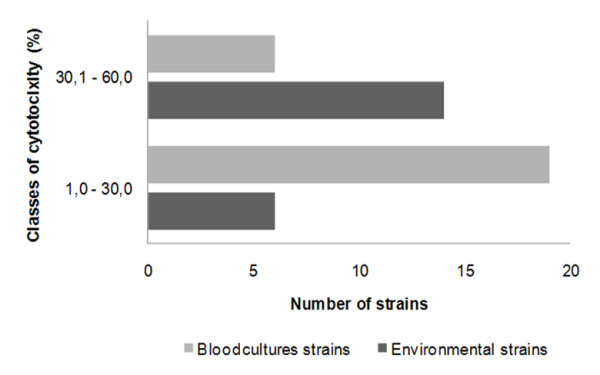
Distribution of C. parapsilosis environmental and blood isolates, according to the defined classes of cytotoxicity. The majority of environmental isolates are included in the group causing between 30 and 60% cytotoxicity. Cellular damage induced by the yeast was quantified as the amount of LDH release by macrophages after 12 hours of infection.